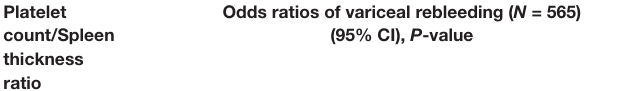
TABLE 3 | Adjusted effects of the platelet count/spleen thickness ratio on rebleeding within one year in cirrhotic patients with moderate or severe. Platelet count/Spleen thickness